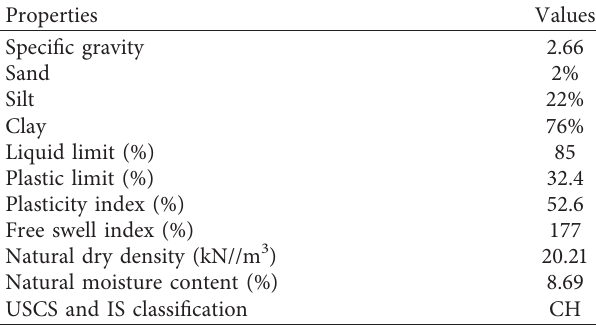
Table 1: Properties of used expansive clay